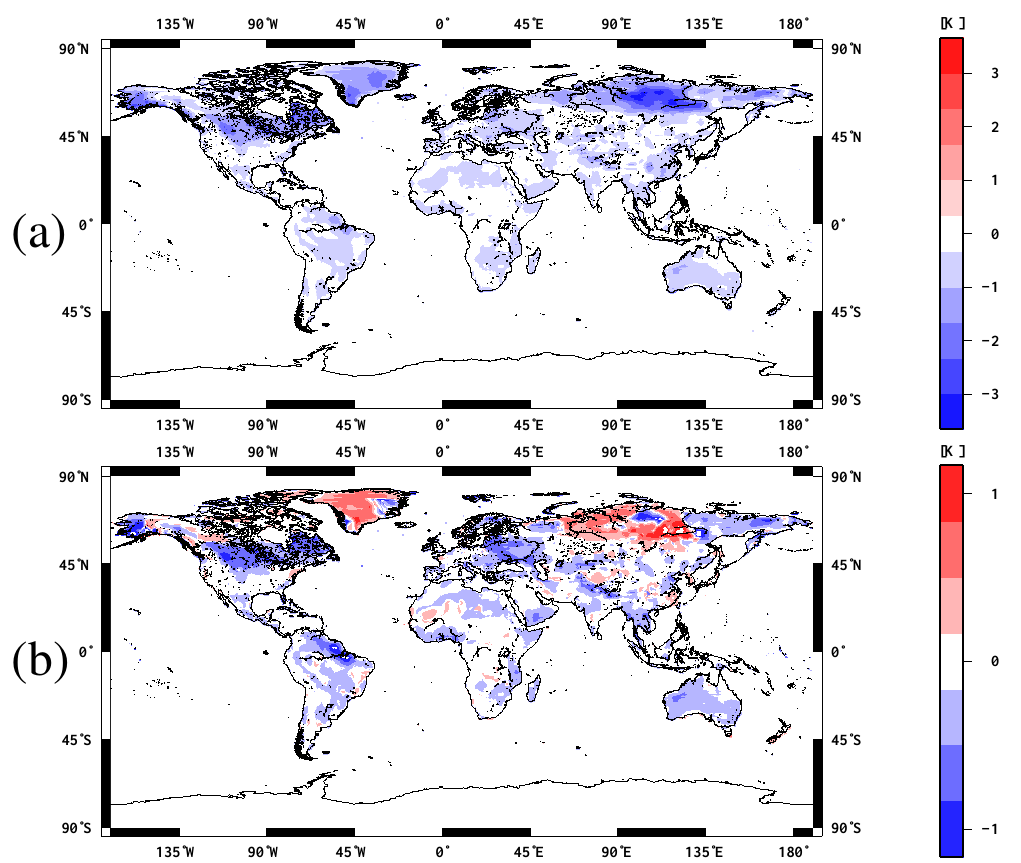
Fig. 3. Temperature bias correction data for ECHAM5 corrected using EU-WATCH forcing data for the years 1960–1999 for Decem- ber: Improvement in standard deviation between original and bias corrected model (negative values mean improvement); (a) , daily values; (b) , monthly mean values.